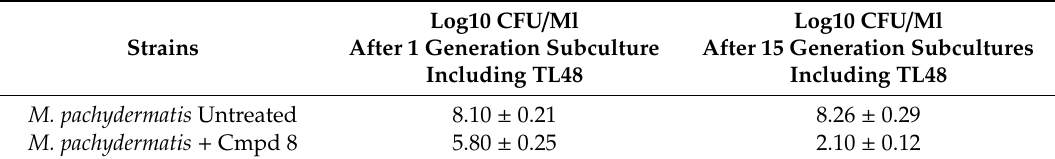
Table 2. Resistance acquisition tests to 3.12 μ M of cmpd 8 . Each experiment is the result of three independent experiments performed in triplicate.